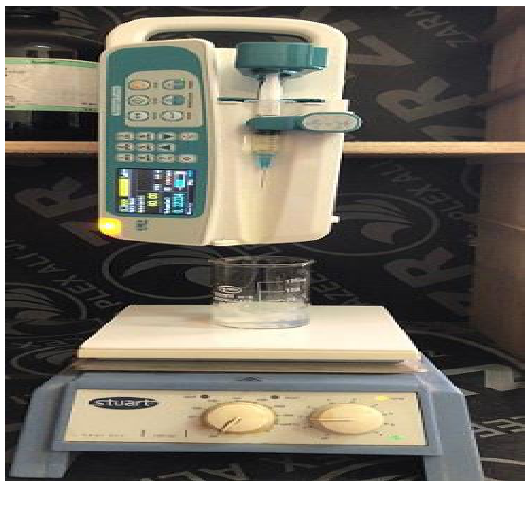
Figure 2. Preparation of